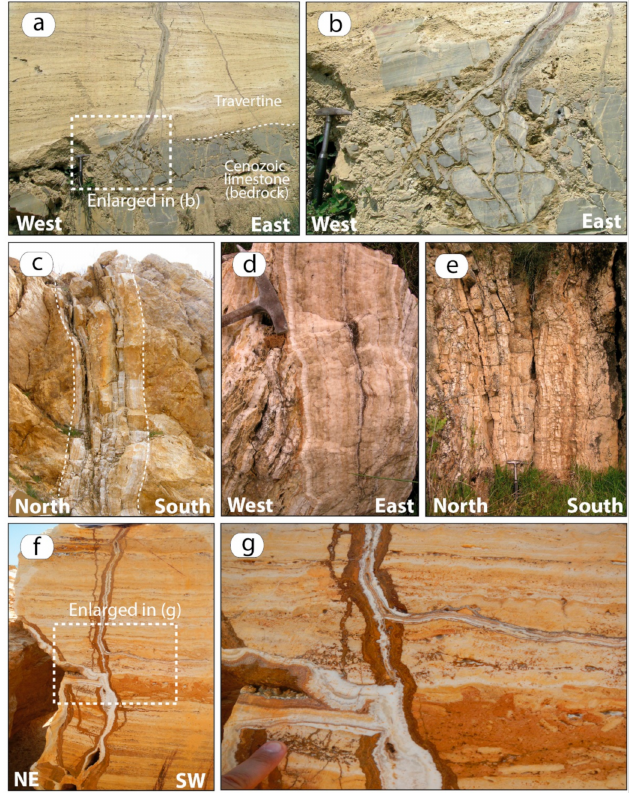
Figure 3. ( a , b ) Banded Ca-carbonate vein filling a fracture affecting travertine deposits and their substratum (from Bagno Vignoni, Italy); ( c ) An example of a vertical banded Ca-carbonate vein crossing travertine deposits (Denizli Basin, Turkey); ( d ) Cross-cutting relationships within a banded Ca-carbonate vein (Sant’Antimo quarry, Italy); ( e ) Multiple symmetrical banded Ca-carbonate veins (Denizli Basin, Turkey); ( f , g ) Christmas-tree-shape banded Ca-carbonate veins crossing travertine deposits (Akkoy,